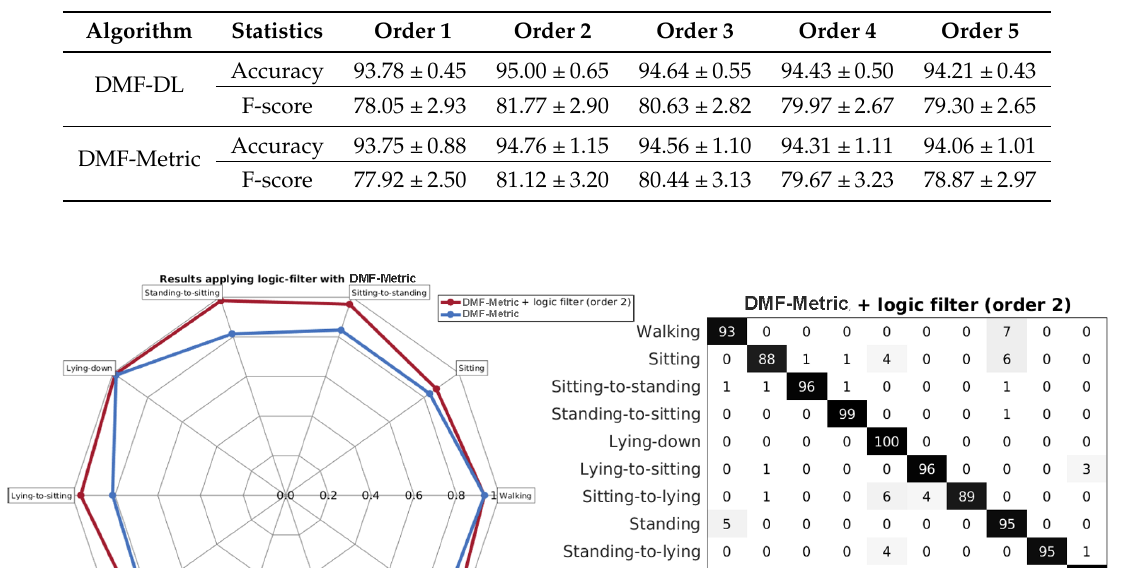
Table 2. Statistical performance results for DMF-DL and DMF-Metric with activated logic filter.